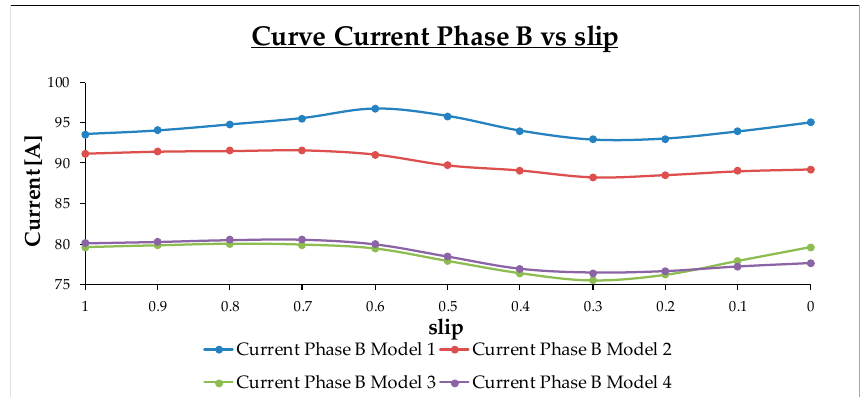
Figure 33. Electric current phase B versus slips.